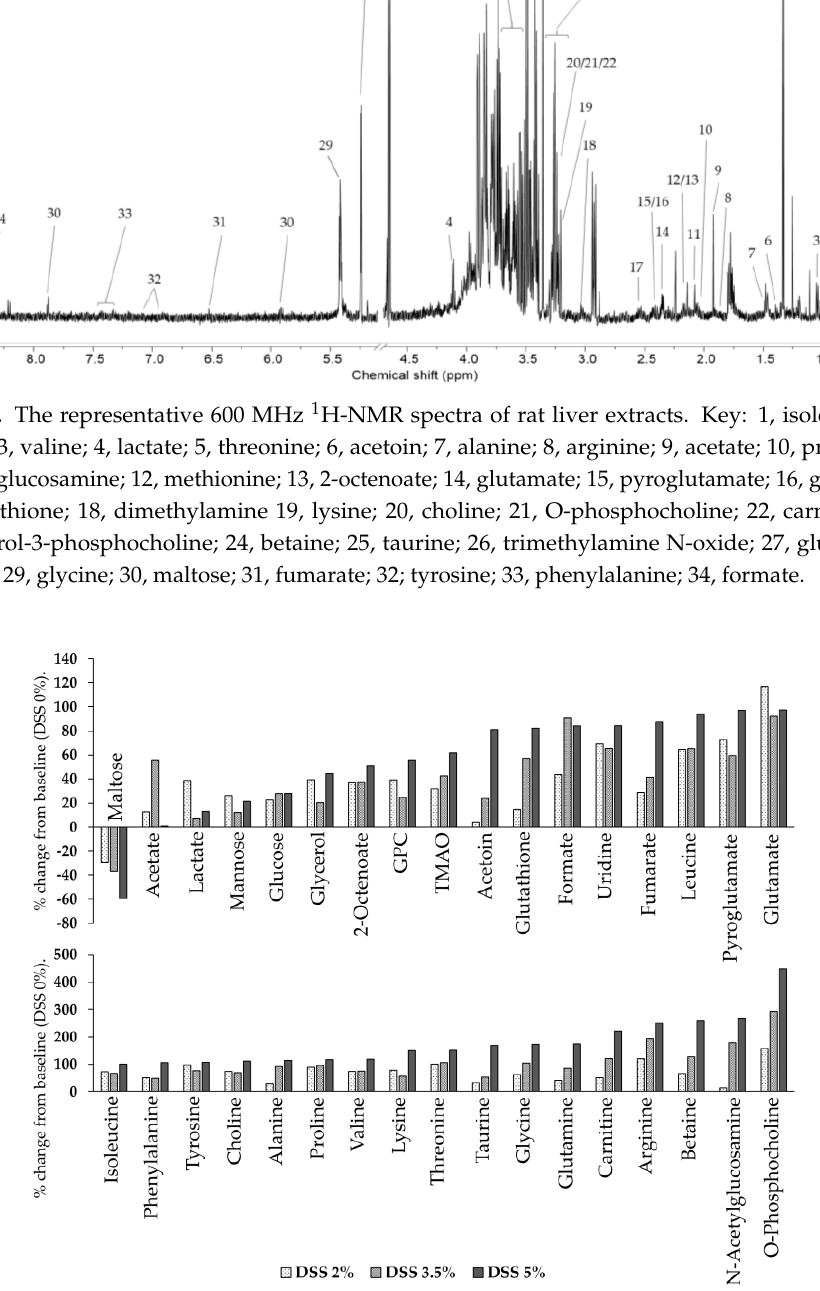
Figure 6. The percent change in metabolite levels in the DSS-treated mouse liver relative to the control mouse liver. % Change = ([DSS-treated liver]–[control liver])/[control liver] × 100). The concentrations of metabolites were calculated through the integration of peak areas using Chenomx. GPC, sn-Glycero-3-phosphocholine; TMAO, Trimethylamine N-oxide.